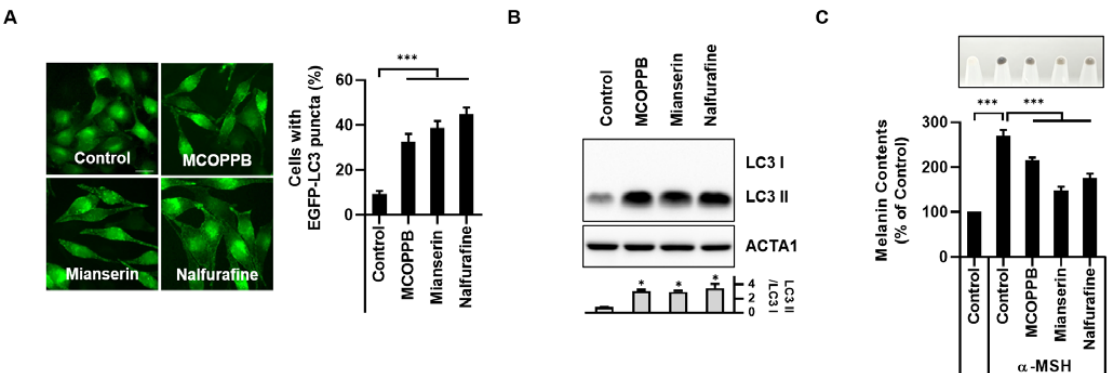
Nalfurafine hydrochloride is a selective kappa ( κ )-opioid receptor agonist [28].